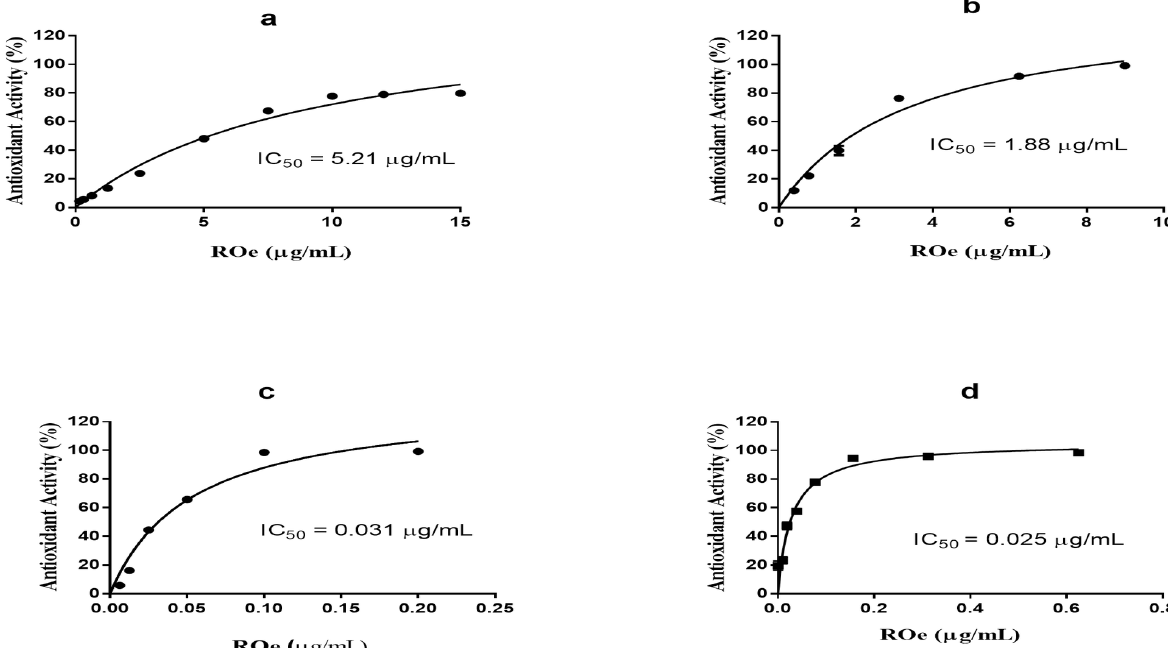
Figure 1. In vitro antioxidant activity of ROe. The extract was added at indicated concentrations and assayed for scavenging the radical DPPH ( a ), radical ABTS ( b ), inhibition of light emission from H xanthine/luminol/XOD ( d ) luminescent reactions with